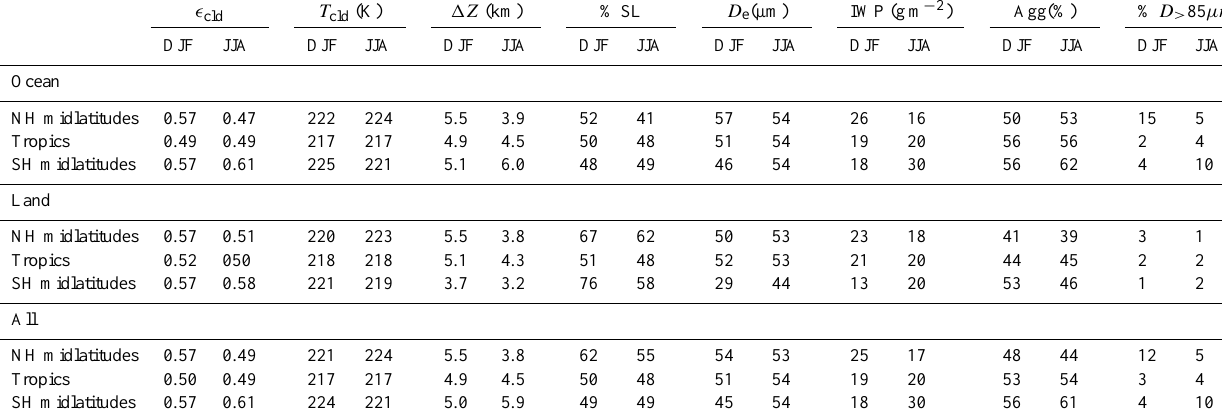
Table 4. ST-HIC means of physical properties and medians of bulk microphysical properties over the period 2003–2009, in three latitude